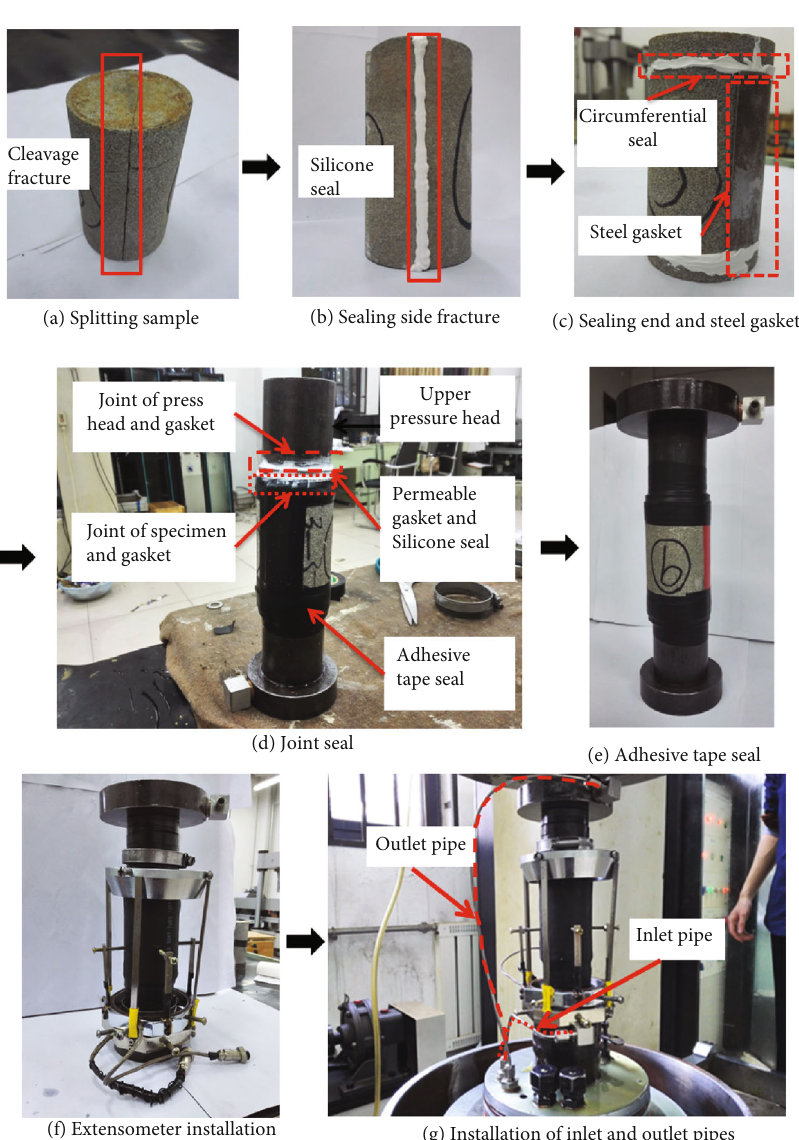
Figure 7: Sample mounting process: (a) splitting sample; (b) sealing side fracture; (c) sealing end and steel gasket; (d) joint seal; (e) adhesive tape seal; (f) extensometer installation; (g) installation of inlet and outlet pipes. Table 2: Seepage test load.